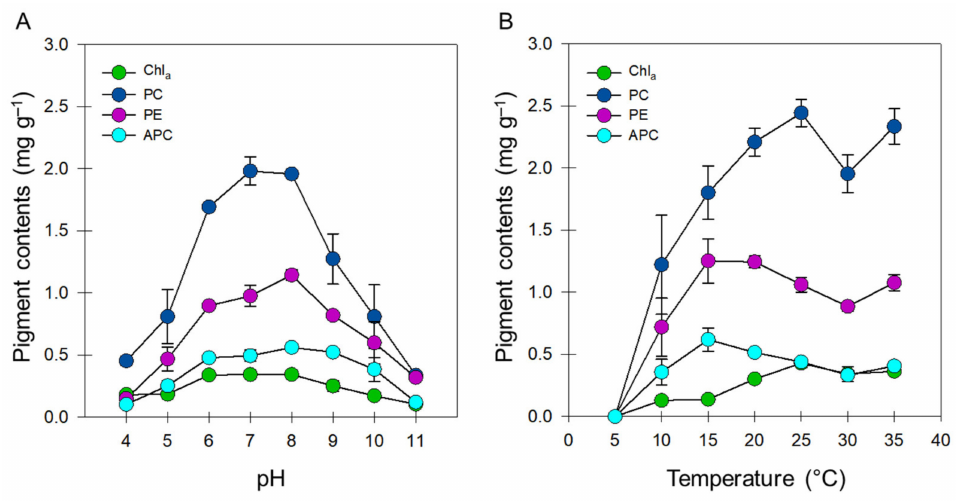
Figure 2. Effect of pH ( A ) and temperature ( B ) on pigment concentrations in A. maxima cultures. The concentrations of chlorophyll a (green) and phycobiliproteins including phycocyanin (navy), allophycocyanin (sky blue), and phycoerythrin (pink). Data represent mean ± SD ( n = 6). For phycobiliproteins, PC concentration was highest at pH 7 (1.98 mg · g − 1 ),